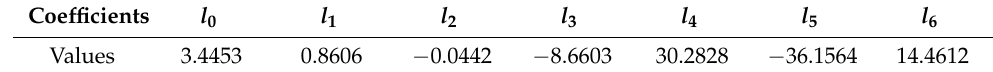
Table 4. Polynomial coefficient of SOC-OCV curve